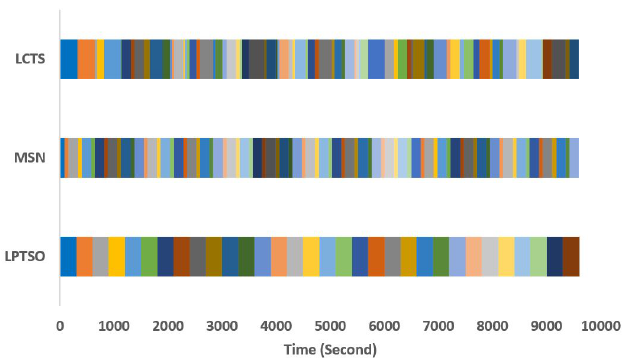
Figure 8. ISL duration with three different methods.